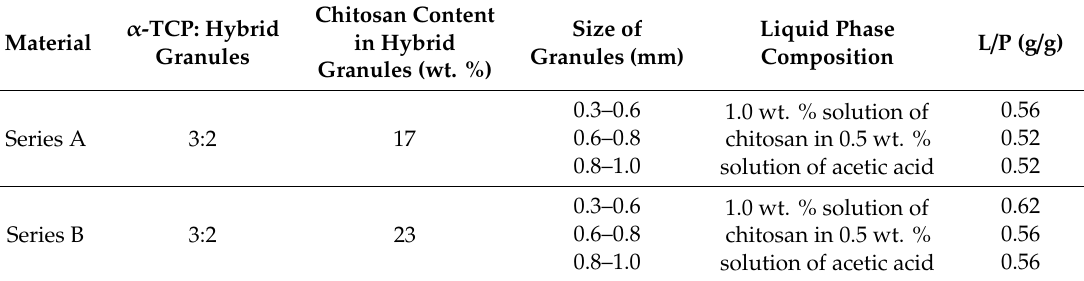
Table 1. The composition of solid and liquid phases of biomicroconcretes.